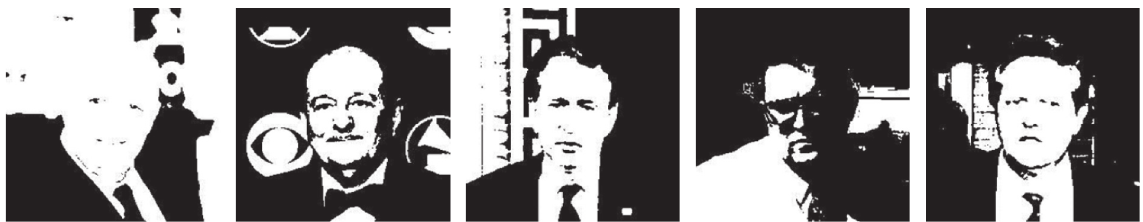
Figure 3: Binary image after filtering connected